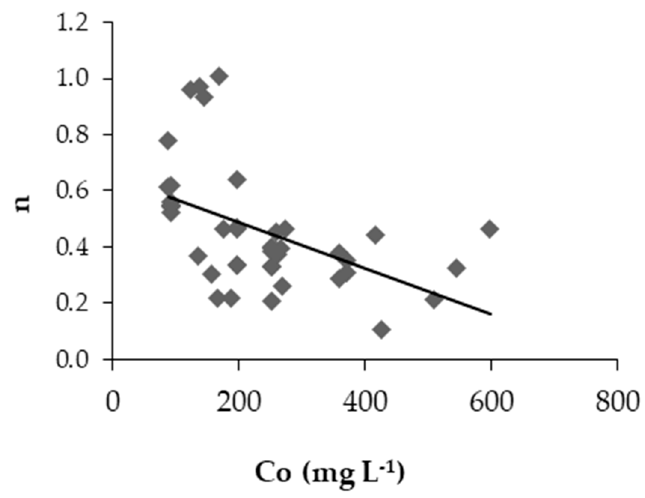
Figure 2. Association (trend) between the n coefficient and Co (as chemical oxygen demand).